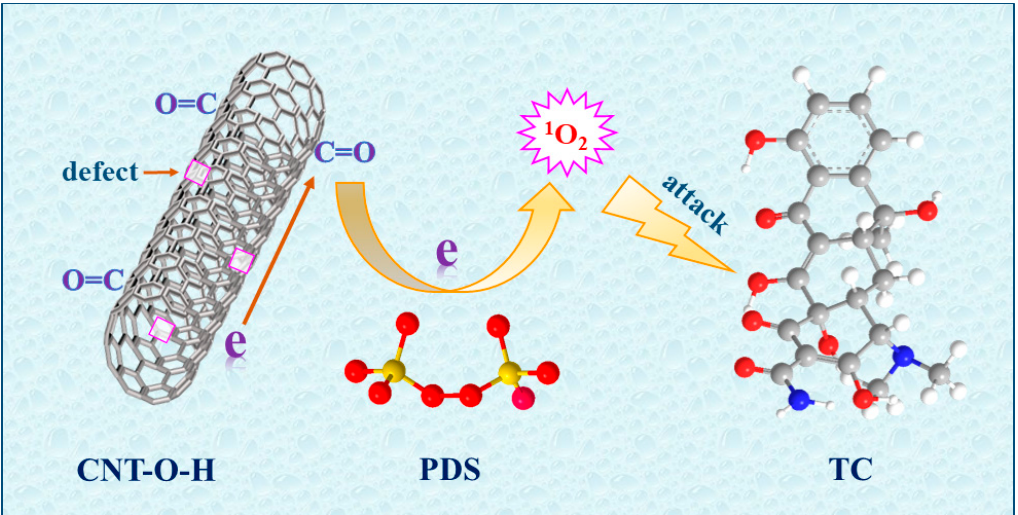
Figure 10. Schematic diagram for TC degradation in the CNT-O-H/PDS system.